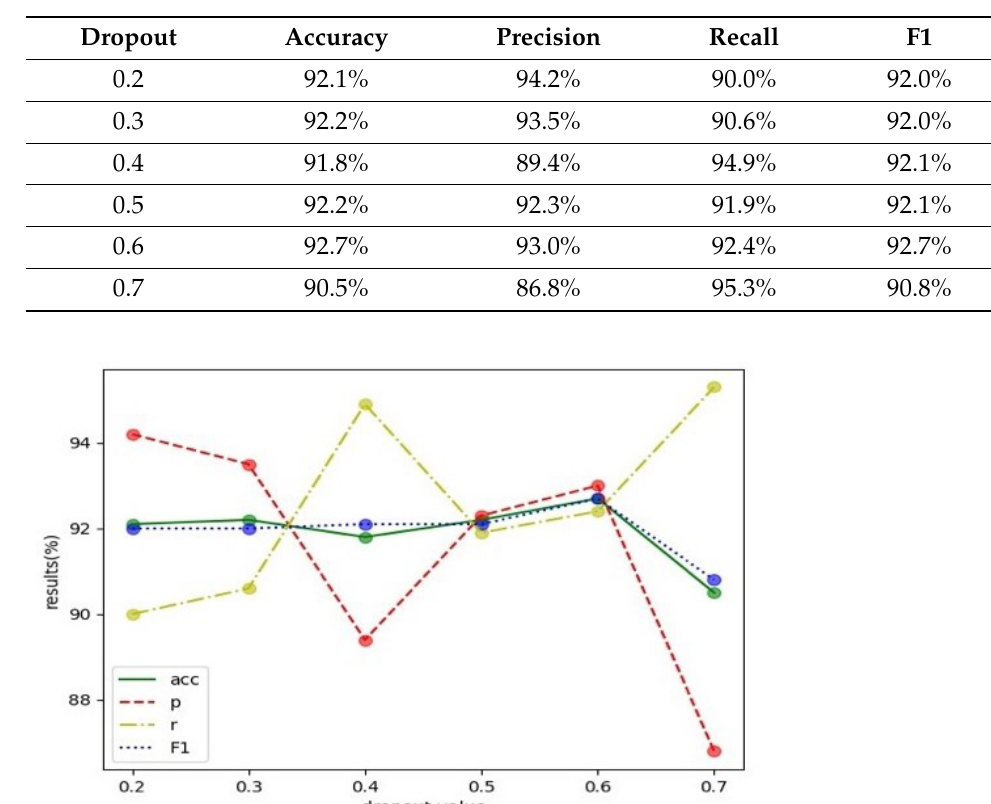
Figure 6. Experimental results of text length. Table 4. Experimental results of dropout value.